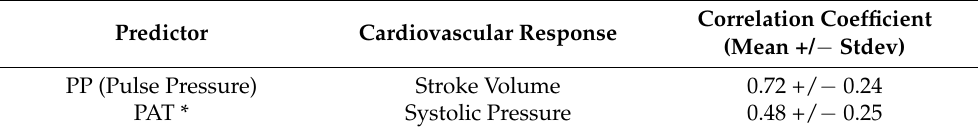
Table 5. Correlation coefficients for estimated and true cardiovascular parameters averaged across all participants. PAT: pulse arrival time.